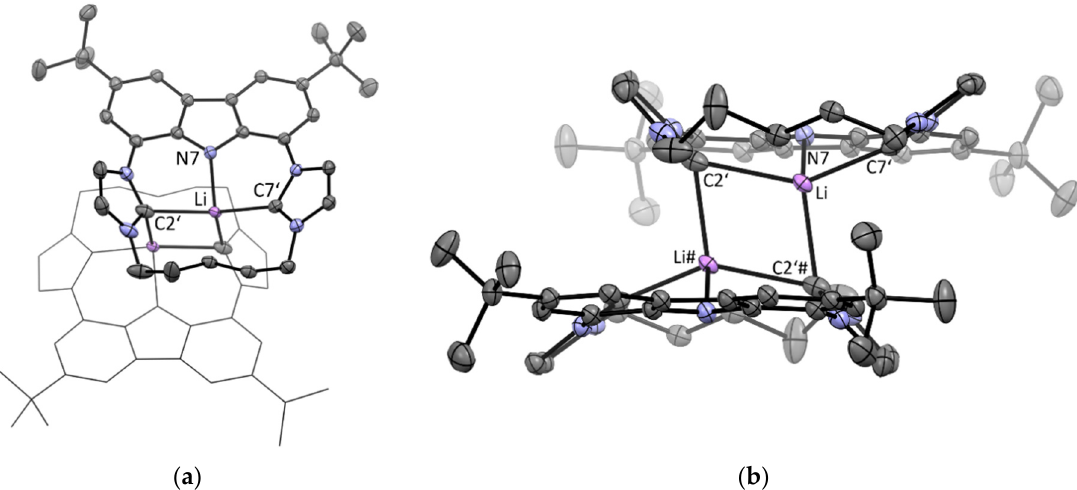
Figure 1. ORTEP-style plot of the molecular structure of [Li(bimca C5 )] ( 2 ) in the solid state (anisotropic atomic displacement parameters at the 50% probability level). Hydrogen atoms are omitted for clarity. Multiple disordered solvent was removed applying the SQUEEZE routine. ( a ) Top view; the wireframe style of the symmetry equivalent lower part is used for clarity; ( b ) side view.